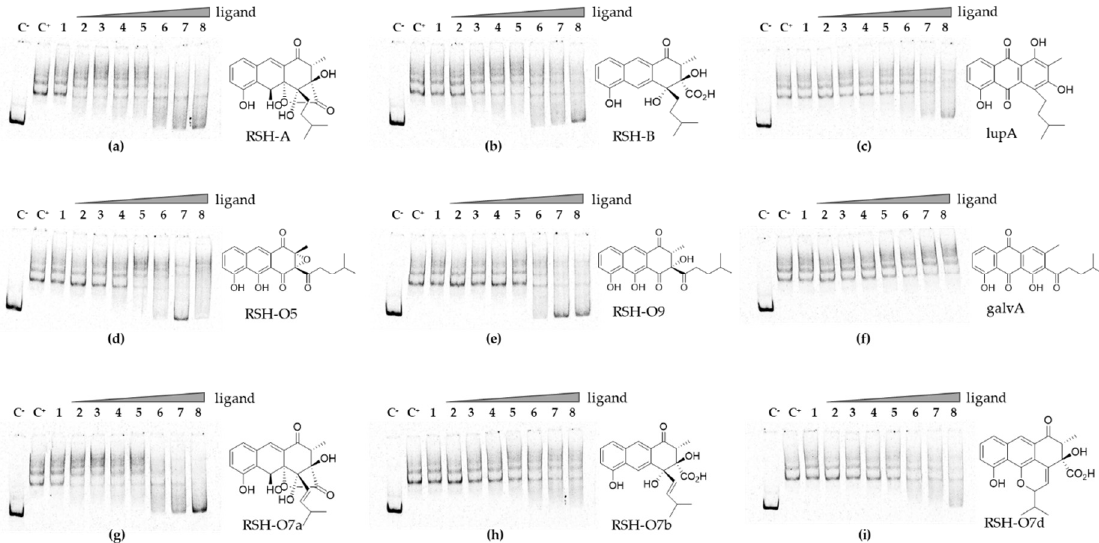
Figure 6. Electrophoretic mobility shift assay used to analyze effects of ligand molecules on RslR4 binding to the rslR4-T4 region. RslR4 (100 nM) was incubated with the rslR4-T4 region and increasing concentrations of the ligands ( a ) rishirilide A, ( b ) rishirilide B, ( c ) lupinacidin A, ( d ) pathway intermediate RSH-O5, ( e ) pathway intermediate RSH-O9, ( f ) shunt product galvaquinone A, ( g ) RSH-O7a, ( h ) RSH-O7b, ( i ) RSH-O7d. Lanes C − , negative control containing only labeled rslR4-T4 , lanes C + , positive control containing RslR4 and labeled rslR4-T4 , lanes 1, positive control containing DMSO, lanes 2–8, samples containing different concentrations of the ligands (1, 10, 50, 100 µM and 0.25, 0.5, 1 mM, respectively).